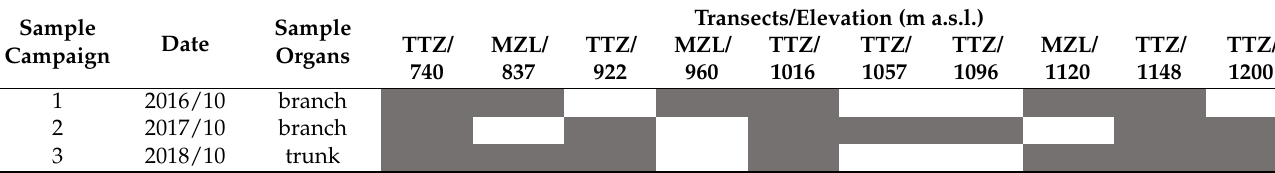
Table 1. Three sampling campaigns between October 2016 and October 2018. The branch samples in- cluded leading twigs and old branches. The color grey denotes the elevation where sample collections were taken along the two elevational transects in Tiantangzhai (TTZ) and Mazongling